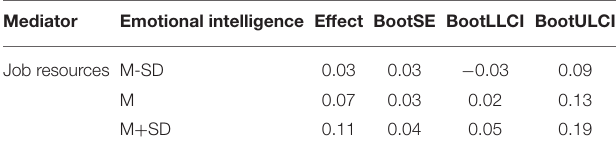
TABLE 3B | Conditional indirect effect of emotional intelligence when job resources mediated between organizational climate and nurse